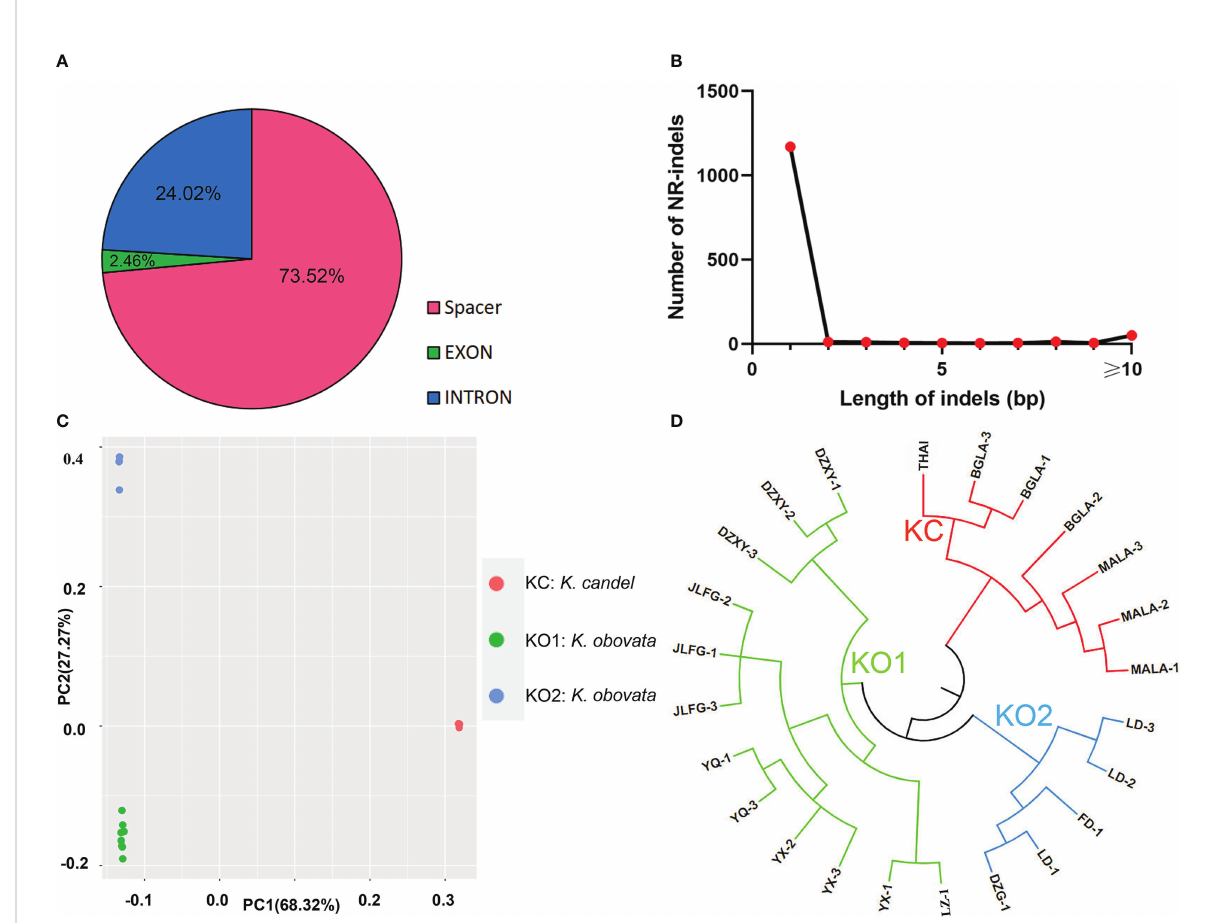
FIGURE 4 Analyses of indels in the chloroplast genomes. (A) Frequency of different indels types and locations. (B) Number and size of non-SSR-related indels in the K . obovata genomes. (C) The PCA result of SNPs. (D) The phylogenetic tree based on SNPs